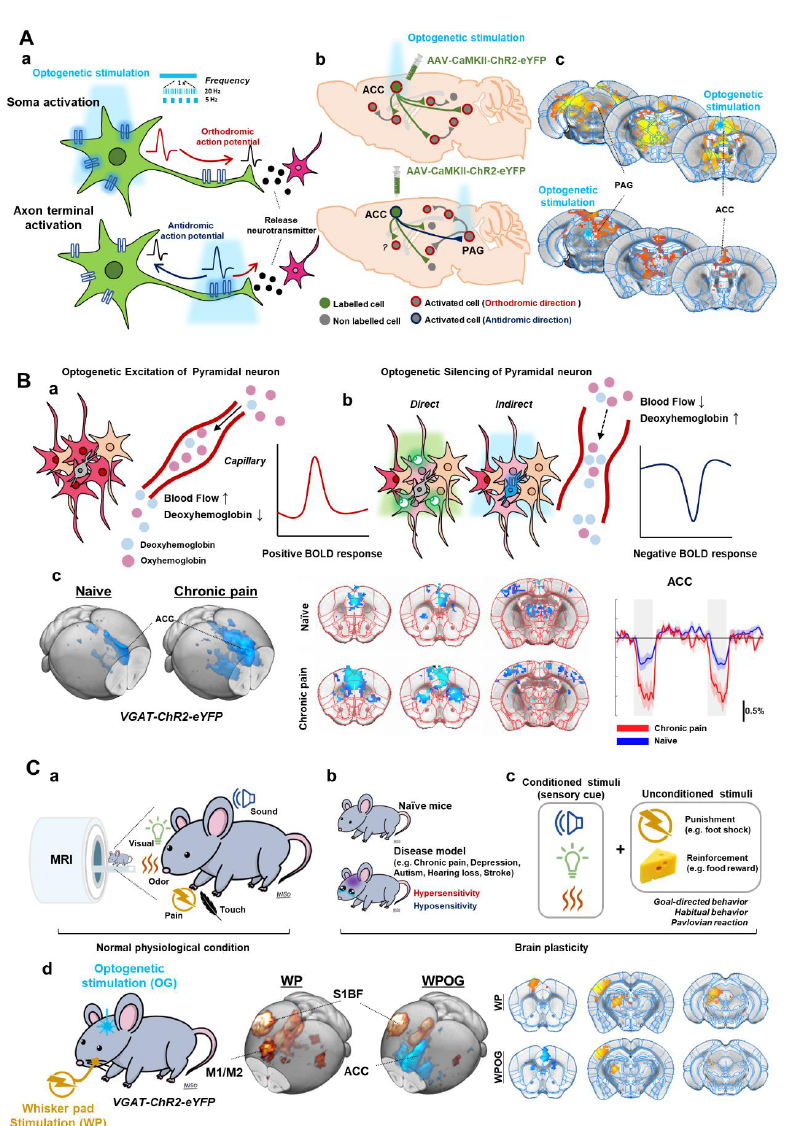
Figure 2. Optogenetic strategies for fMRI. ( A ). Optogenetic stimulation of excitatory cell bodies (soma) or axon terminals. Orthodromic and antidromic propagation responding to the stimulating site ( a ). Postsynaptic activities by optogenetic stimulation ( b ). ofMRI response maps induced by optogenetic stimulation; fMRI response map by cell body stimulation of ACC and by axon terminal stimulation of ACC-PAG projection ( c ). ( B ). Optogenetic silencing by inhibitory opsins in excitatory pyramidal neurons ( a ) or excitatory opsins in inhibitory interneurons ( b ). ofMRI response of naïve and CFA-induced chronic pain model mice during ACC inhibition ( c ). ( C ). Combining optogenetics with sensory-evoked fMRI. fMRI with sensory stimuli (sensory-evoked fMRI) ( a ). Applying sensory- evoked fMRI to animal disease models ( b ) or conditioning behaviors ( c ). Silencing ofMRI combined with electrical stimulation ( d ). Adapted with permission from Lee et al. (2022) [20]. ACC; anterior cingulate cortex, PAG; periaqueductal